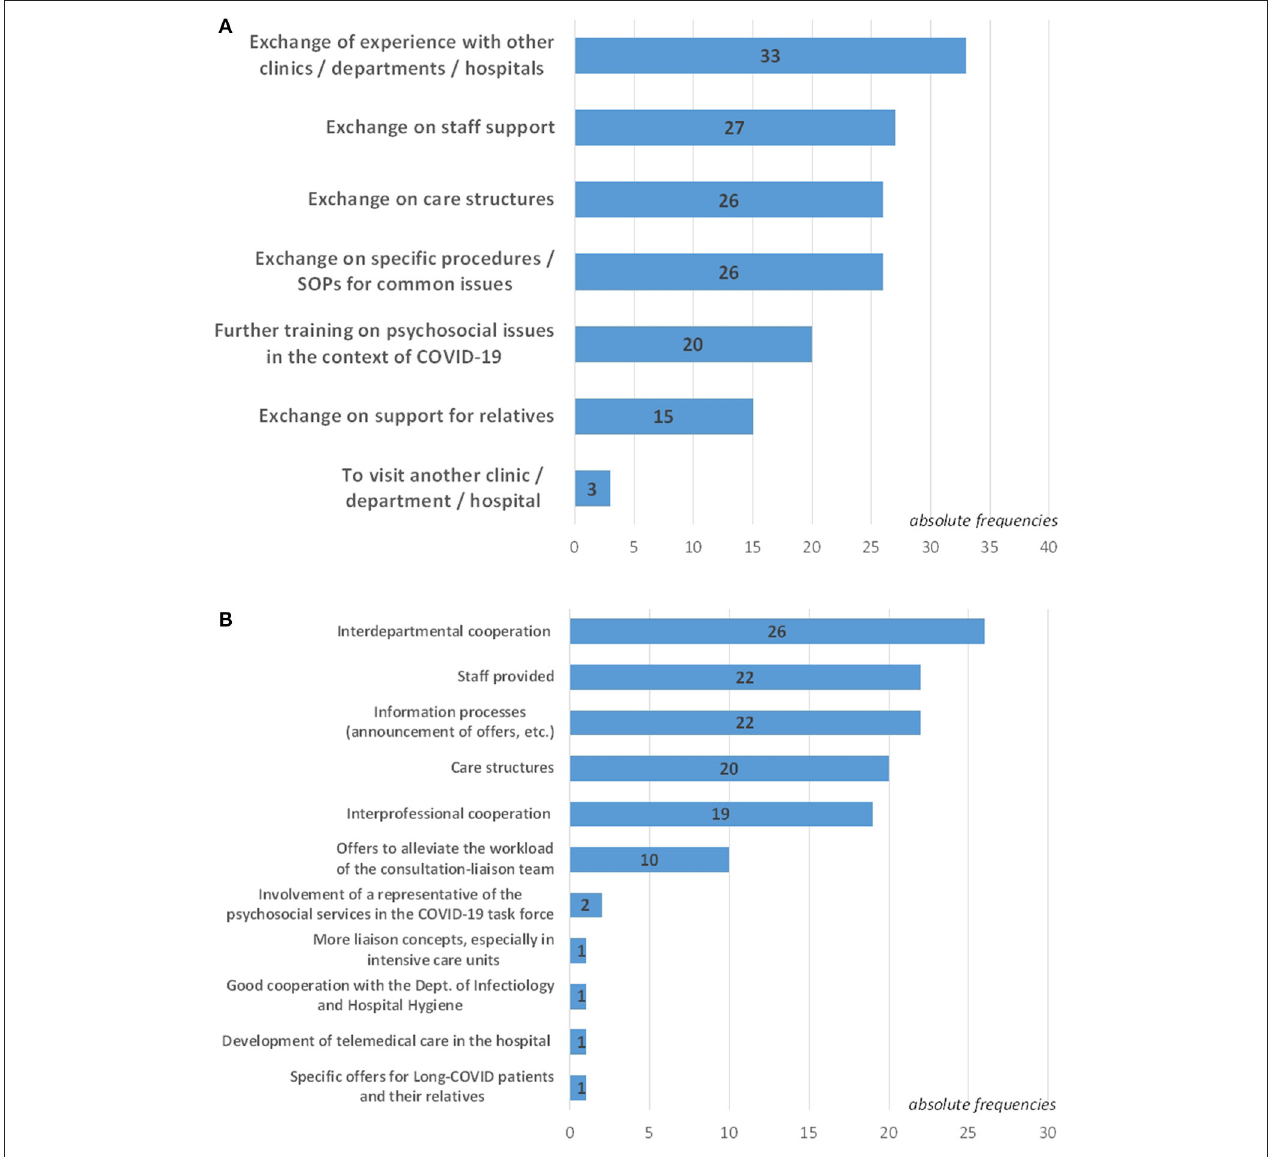
FIGURE 7 | Needs and requests for the future. (A) Specification of required exchange/support regarding COVID-psyCare ( n = 37). ( B) Specification of changes/improvements that are considered essential for the future with regard to psychosocial care services in one’s hospital in the COVID-19 context ( n =